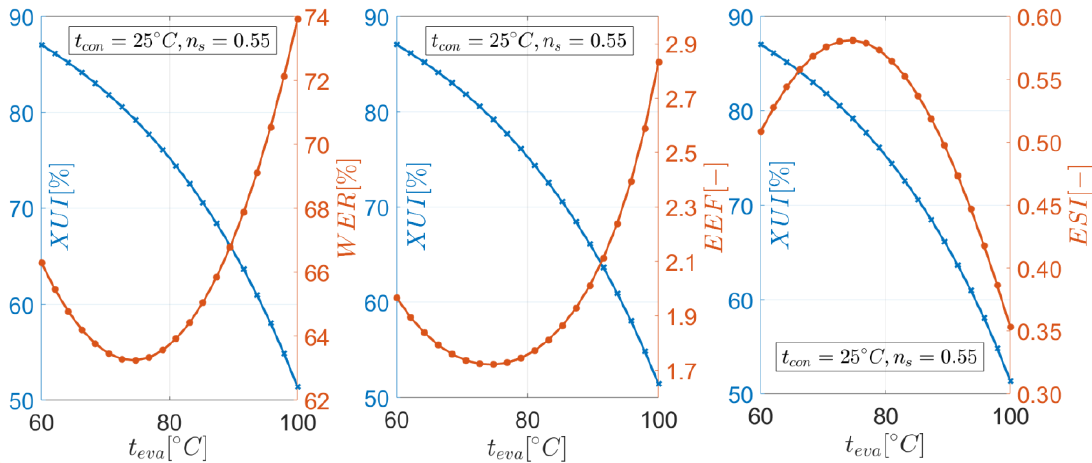
Figure 7. XUI and exergy-related indicators as functions of evaporation temperature t eva.